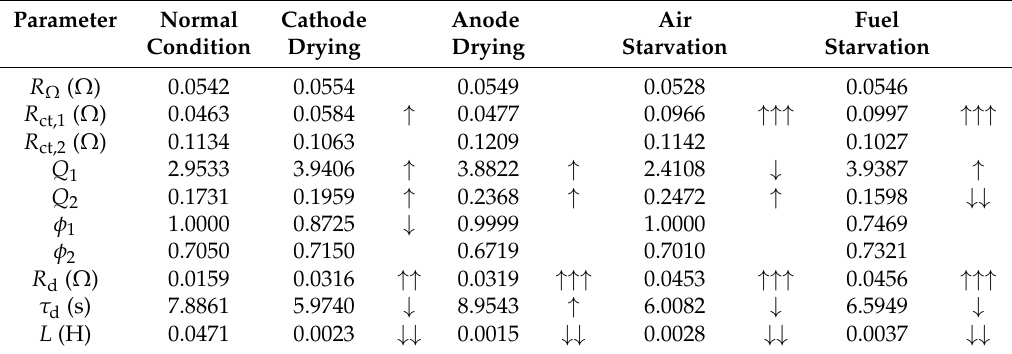
Figure 12. Dataset B. EIS experimental spectra in various operating conditions. x-scale differs from y-scale to highlight the variation of the spectrum. Table 6. Comparison among the parameters identified in various operating conditions at 40A nominal current. The number of arrows highlights, in a qualitative way, the percentage variation x with respect to nominal condition. ↑ : 10% ≤ x < 50%, ↑↑ : 50% ≤ x < 100%, ↑↑↑ : x ≥ 100%. ↓ , ↓↓ , and ↓↓↓ are defined